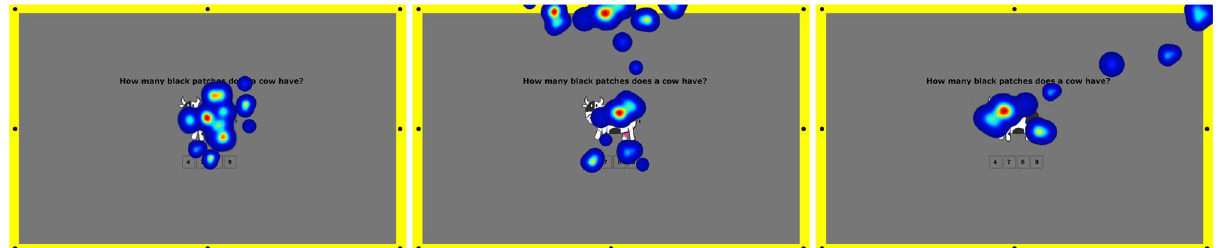
Figure 4. The course of the experiment and the corresponding heat maps. (left) The observer focuses strictly on a given cognitive task: the experiment was conducted properly. (center and right) The user fixed his sight on the stimuli in the peripheral space instead of focusing purely on the cognitive task: the experiment was conducted